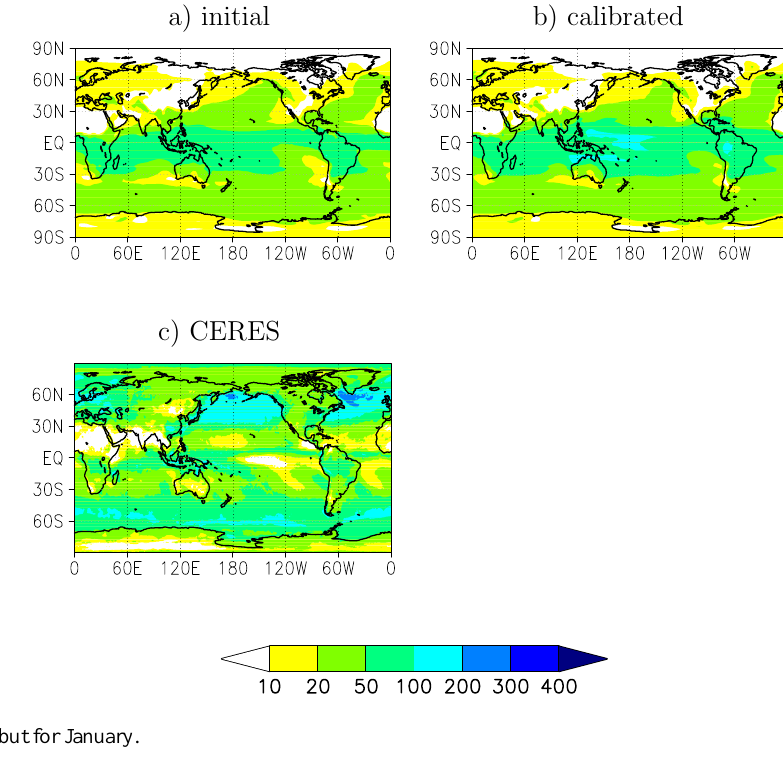
Fig. 8. Similar to Fig. 7 but for January.